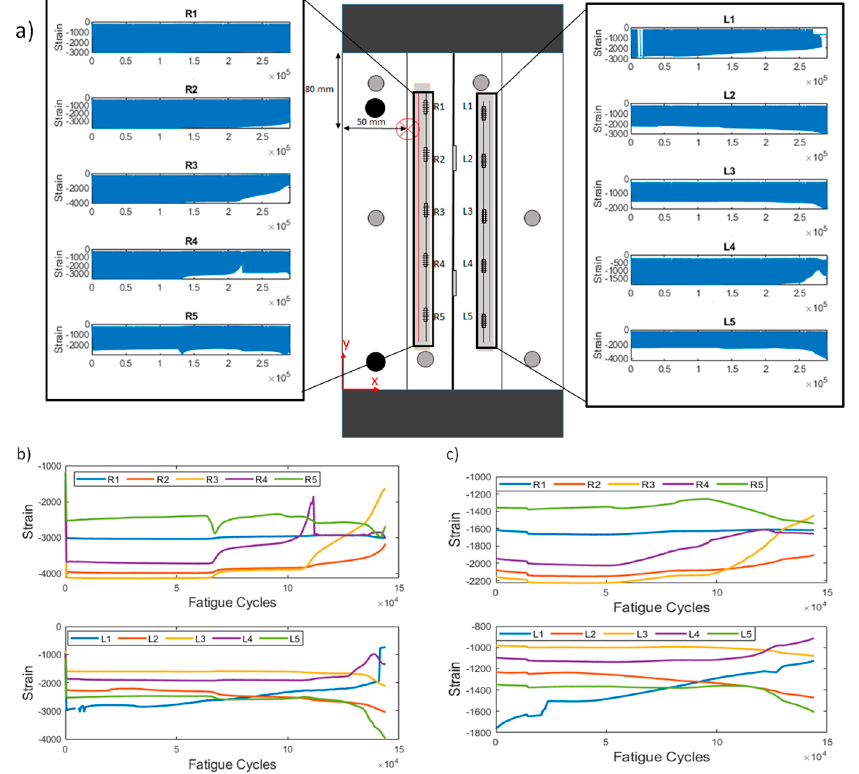
Figure 4. Constant amplitude test specimen CA-2. ( a ) Sensor and damage locations and raw strain data for each FBG. R and L stand for right and left, respectively; ( b ) maximum strain extracted from each quasi-static loading vs. cycles (pre-processing method 1); ( c ) random strains extracted from each quasi-static loading vs. cycles (pre-processing method 2).